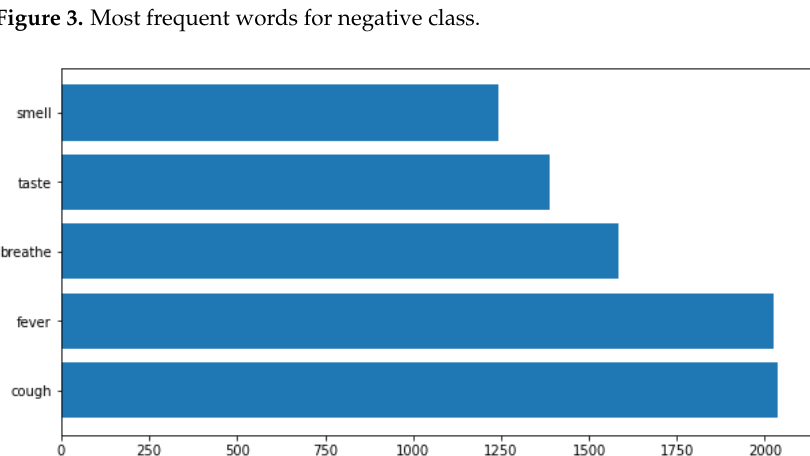
Figure 4. Symptoms that appeared the most in the dataset.